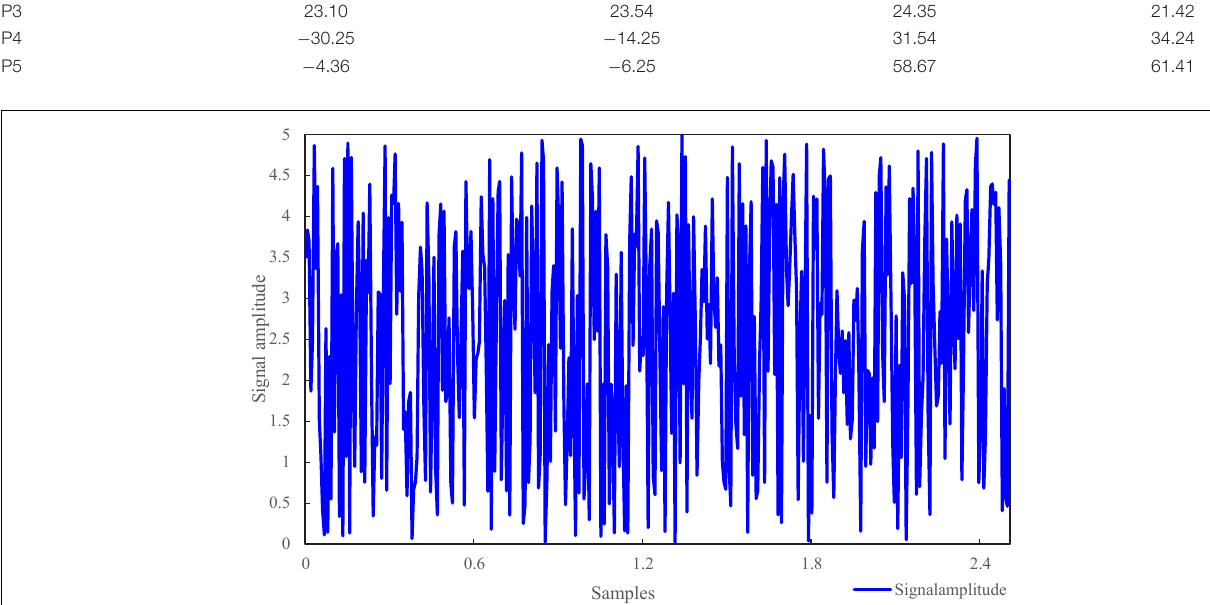
FIGURE 4 | Fluctuation of voice signal.